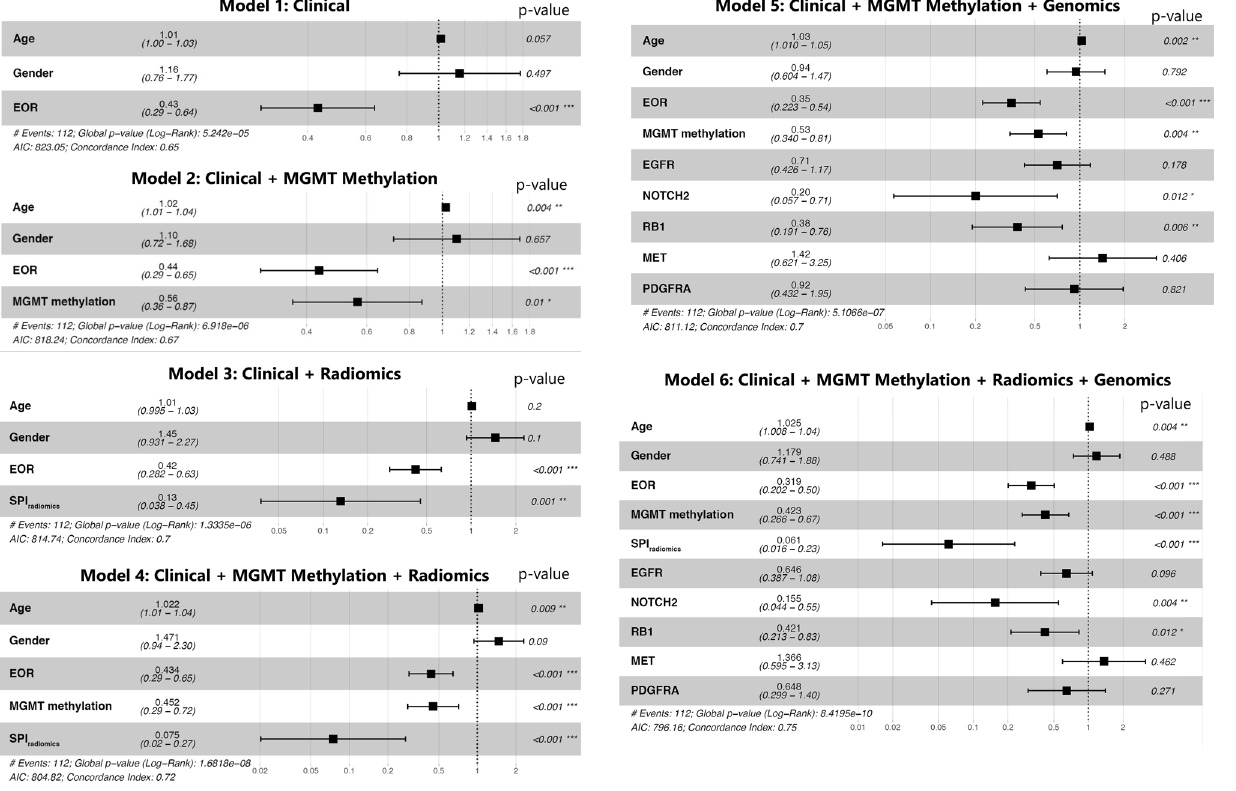
Figure 4. Forest plots for the six presented Cox-PH models, demonstrating the association between each of the covariates and survival. In this plot, x-axis presents hazard ratios (HR) for the covariates in each model (the value of HR and confidence intervals for the covariates are provided on the plot as well).